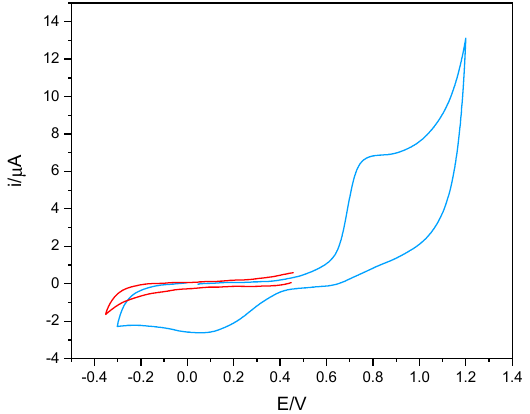
Figure 2. The voltametric behavior of 1 mM phenol in 50% v / v DES-PBS solution (blue line) and cathodic scan of 1 mM phenol in 50% v / v DES-PBS buffer solution (red line). Potential scan rate of 50 mV/s.